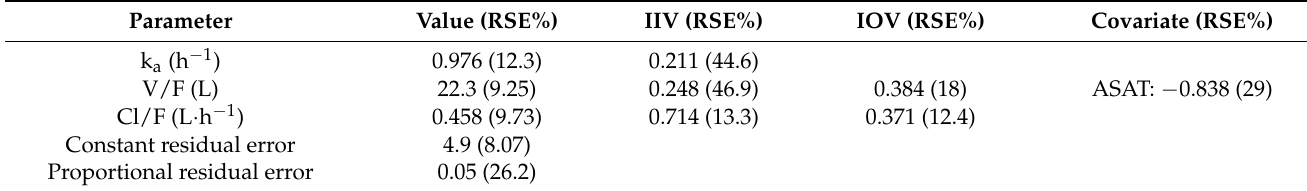
Table 1. Estimated PK parameter of pazopanib with a mono compartmental model.